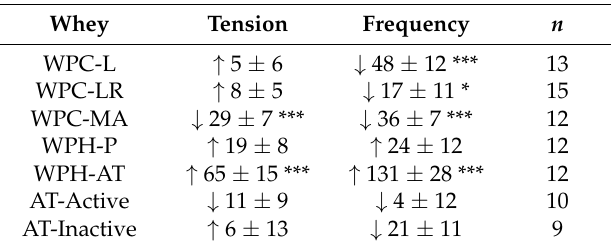
Table 3. Effect of whey proteins on distal colon